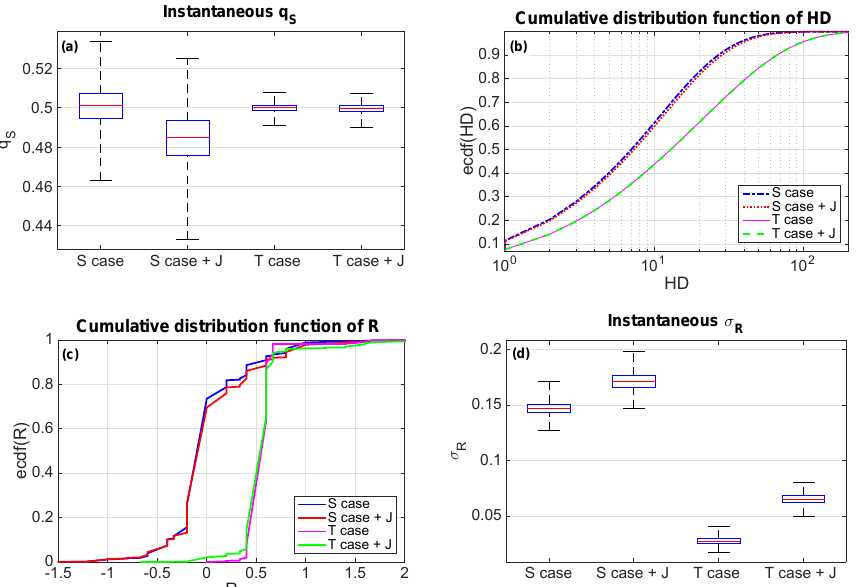
Figure 7. Comparison between stochastic entrainment ( S case without jamming and S case + J with jamming) and deterministic threshold entrainment ( T case without jamming and T case + J with jamming). (a) Box plots of the instantaneous values of specific sediment flux q S . (b) Empirical cumulative distribution function of particle hop distances HD. (c) Empirical cumulative distribution function of relative exposure R computed on the entire control volume at the end of the simulation. (d) Box plots of the instantaneous values of the spatial standard deviation of relative exposure σ R